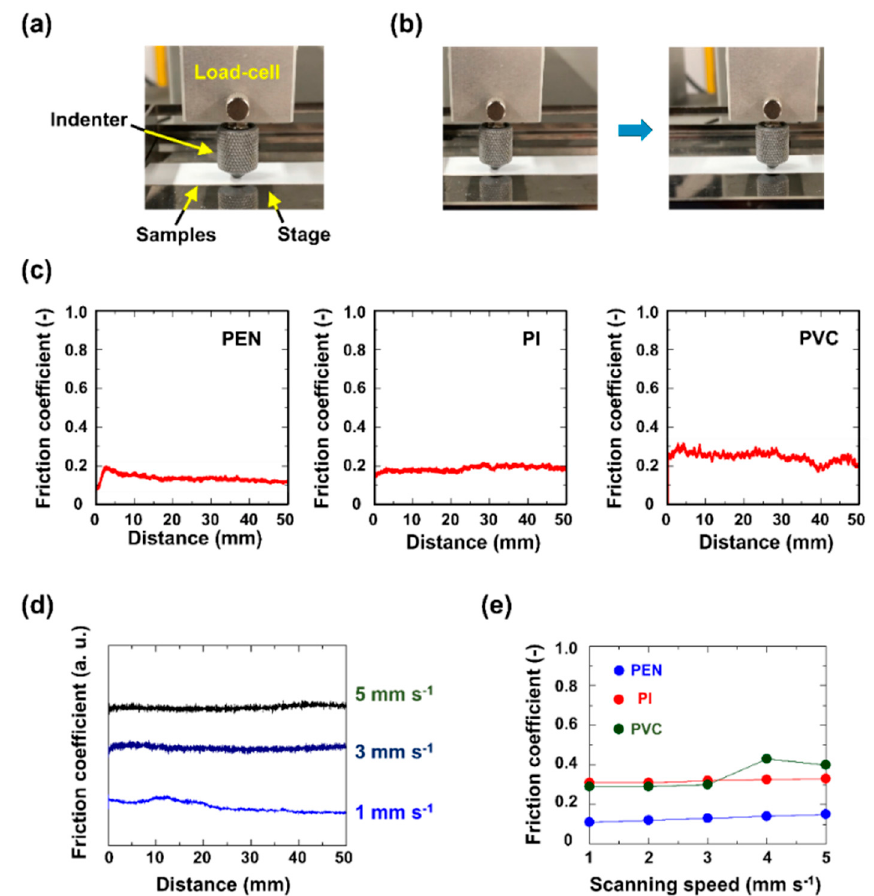
Figure 3. Dynamic friction coefficient measurements: The sensor layers comprised PEN, PI, and PVC films: ( a ) Measurement setup; ( b ) Indenter scanning to perform the measurements; ( c ) Measured friction coefficients of the fractional layers; ( d ) Friction coefficients as a function of the scanning speeds; ( e ) Friction coefficients of the fractional layers as a function of the scanning speeds.